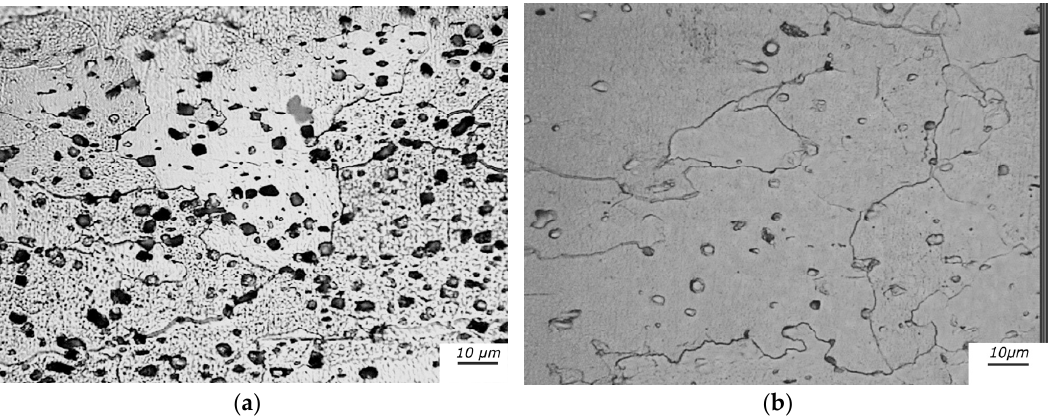
Figure 9. Tungsten B: light microscopy micrographs of the same sample in as ‐ supplied condition ( a ) and after a MS run test ( b ).